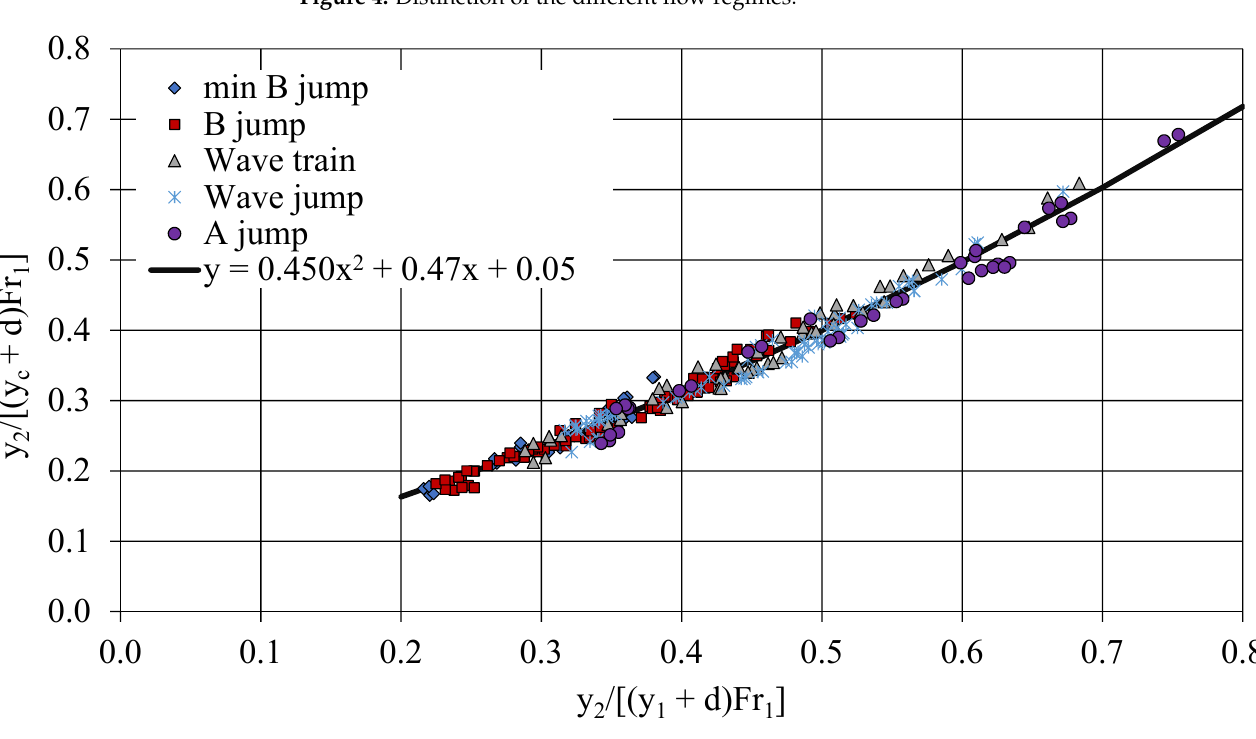
Figure 5. Relationship between y 1 , Fr 1 , d, y c and y 2 .